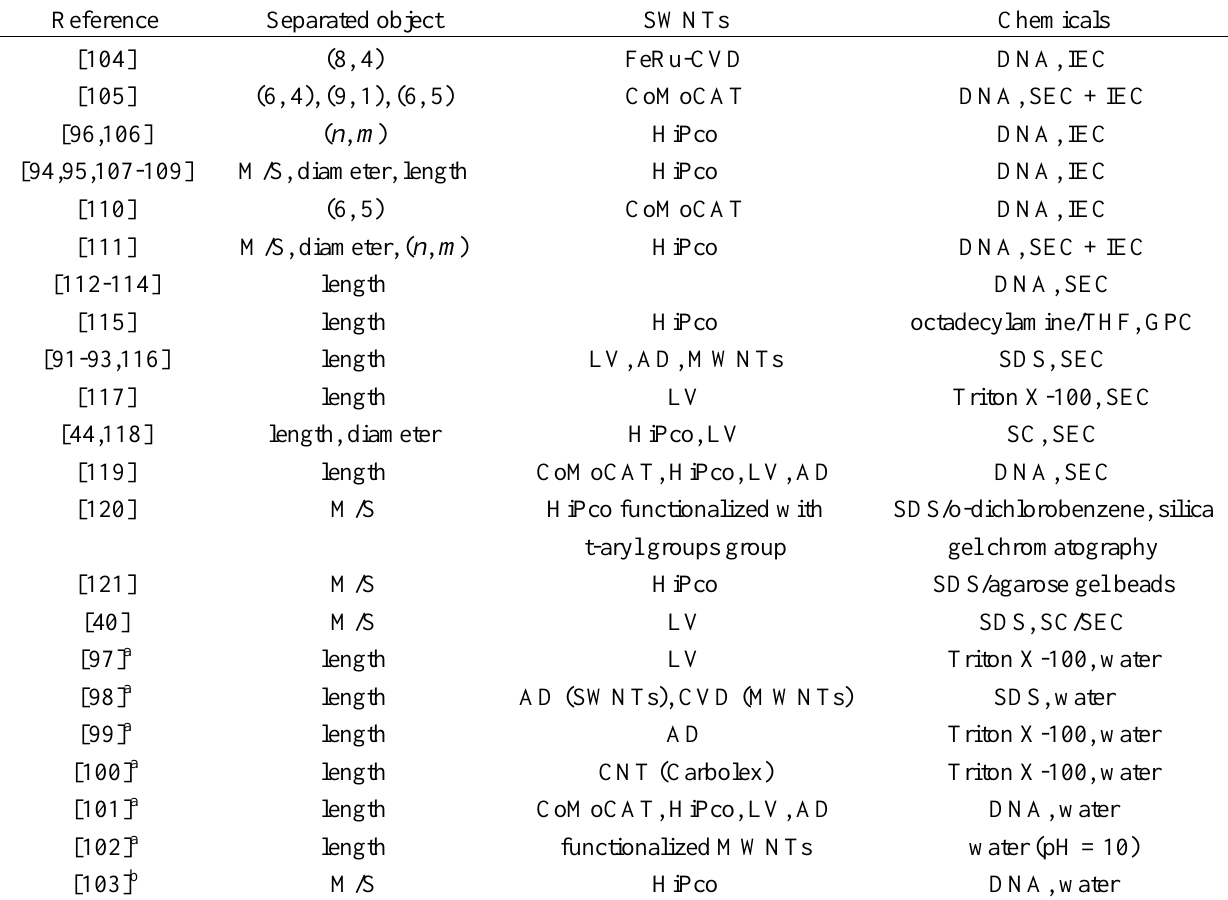
a FFF: Field-flow fractionation, b Optical